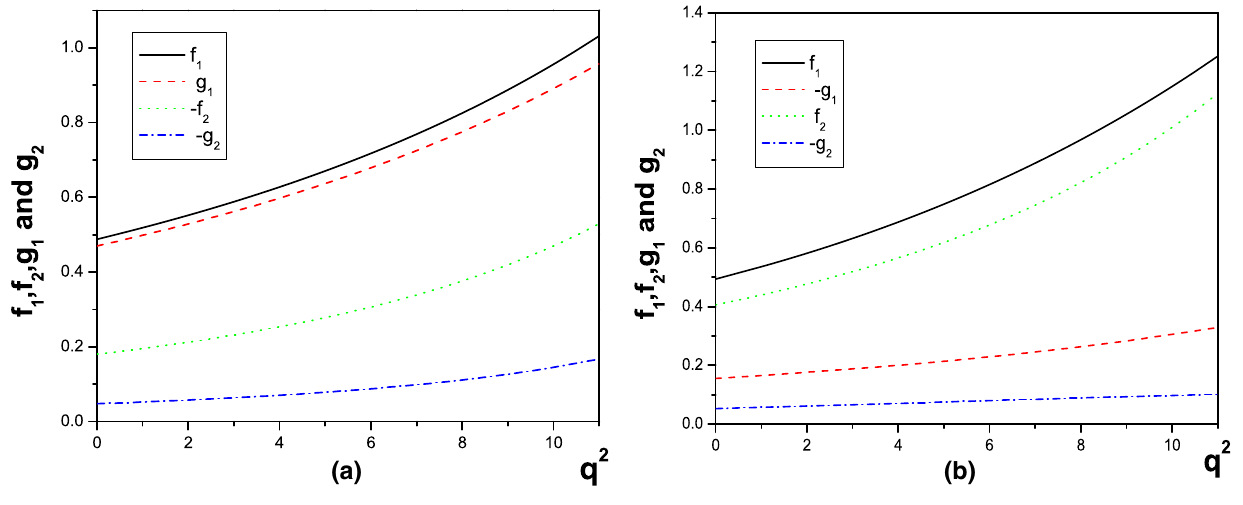
Fig. 2 Form factor for the decay (cid:2) b → (cid:2) c l ¯ ν l ( a ) and (cid:3) b → (cid:3) c l ¯ ν l ( b